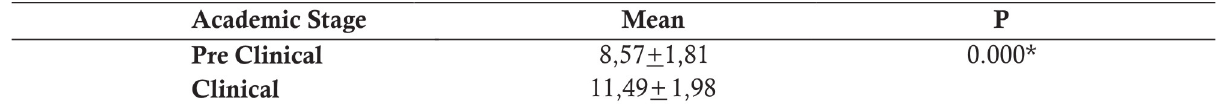
Table . SCT mean score of preclinical and clinical